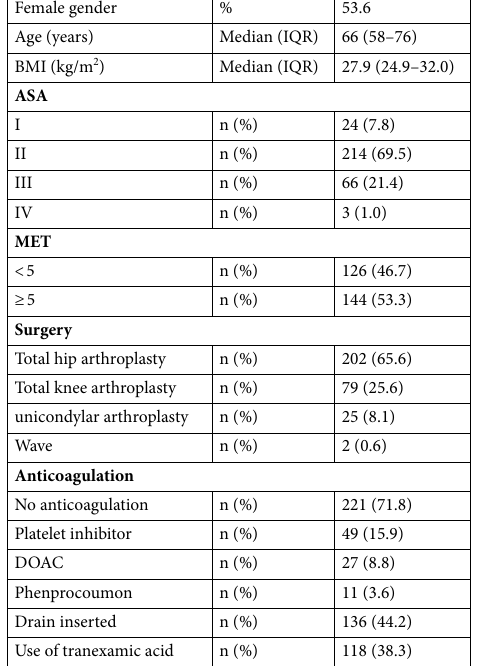
Table 1. Patient characteristics. BMI body mass index, ASA American Society of Anesthesiologists grade, MET Metabolic Equivalent of Task